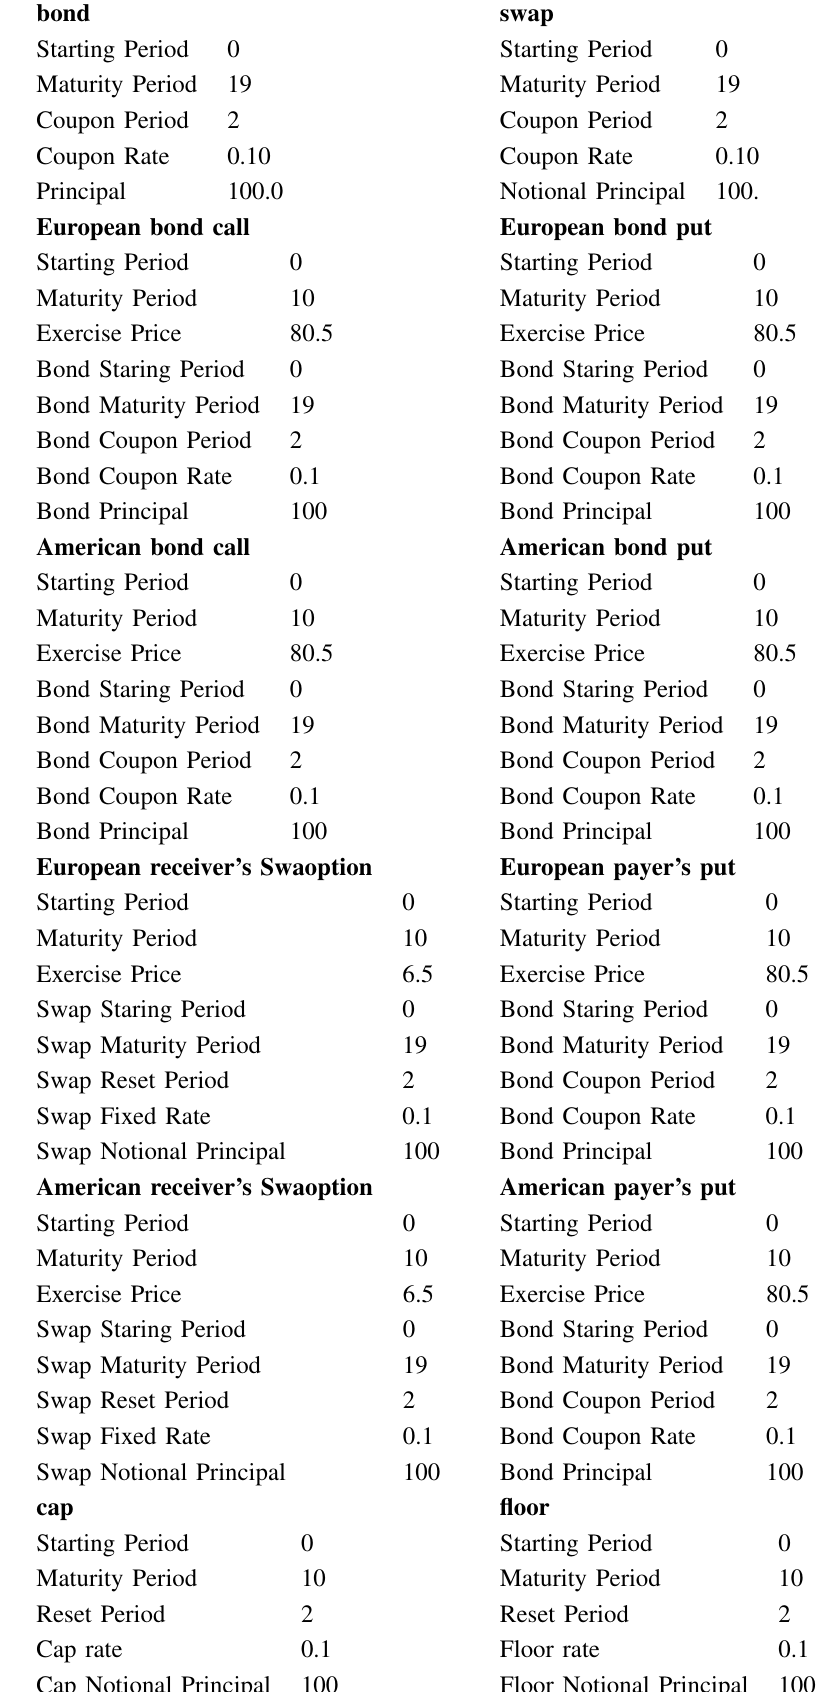
Table 1. Derivative